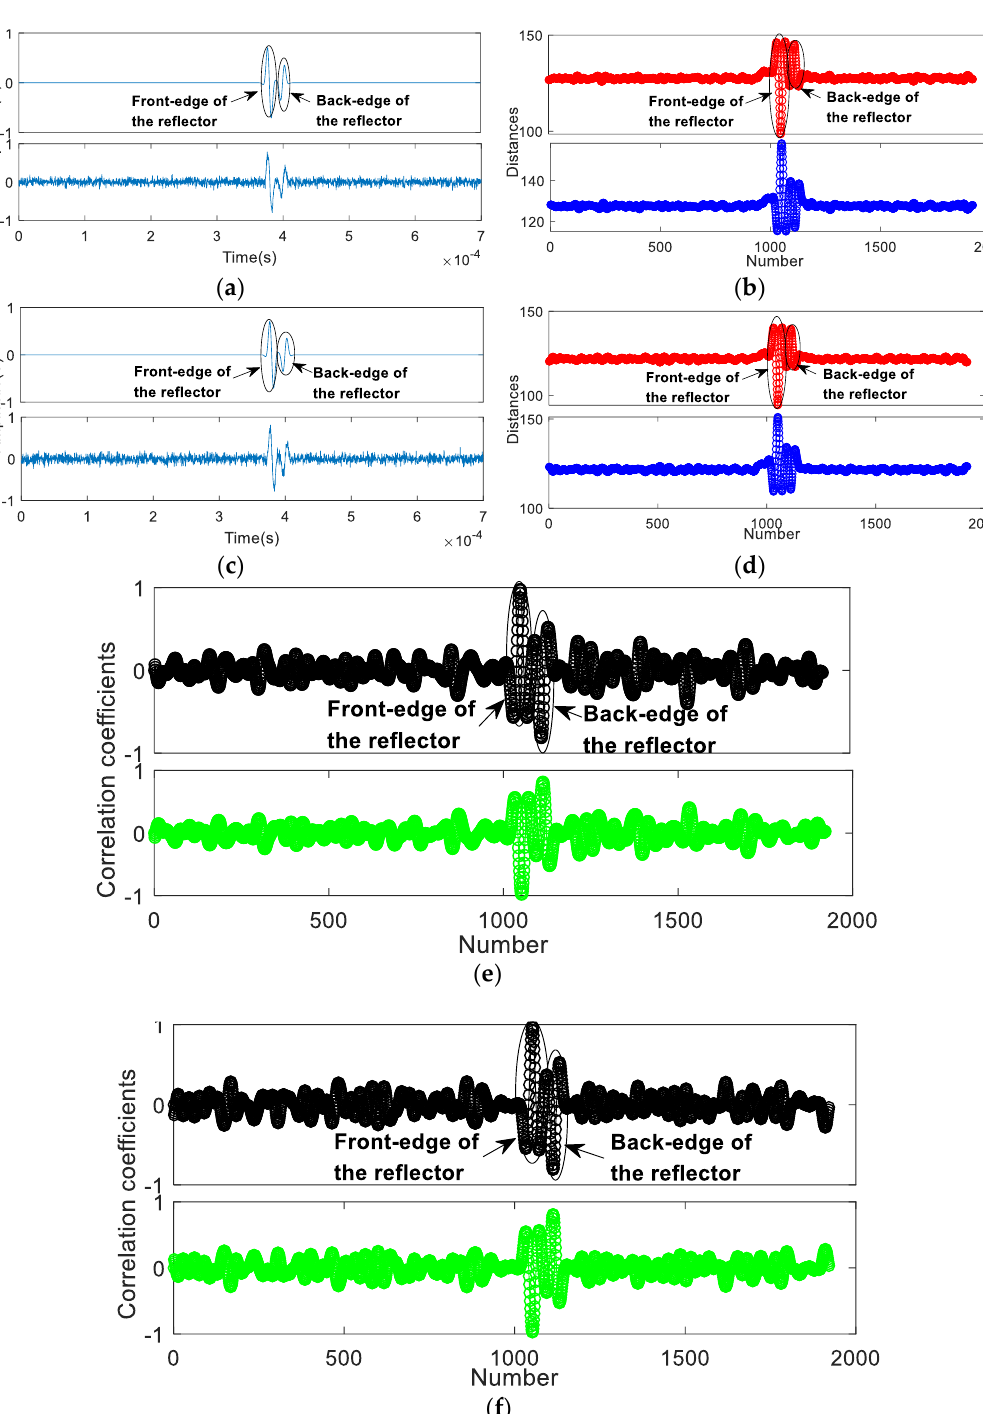
Figure 9. Numerical signals with different SNRs and comparisons of the results by the proposed method and correlation coefficient method; ( a ) 1 ˆ() x t with SNR = 1 dB; ( b ) Distance curves Ψ 1 ( Up ) and Ψ 2 ( Down ) of 1 ˆ() x t ; ( c ) 2 ˆ() x t with SNR = 0.1 dB; ( d ) Distance curves Ψ 1 ( Up ) and Ψ 2 ( Down ) of 2 ˆ() x t ; ( e ) PCCM curves Ψ 1 ( Up ) and Ψ 2 ( Down ) of 1 ˆ() x t ; ( f ) PCCM curves Ψ 1 ( Up ) and Ψ 2 ( Down ) of 2 ˆ() x t .